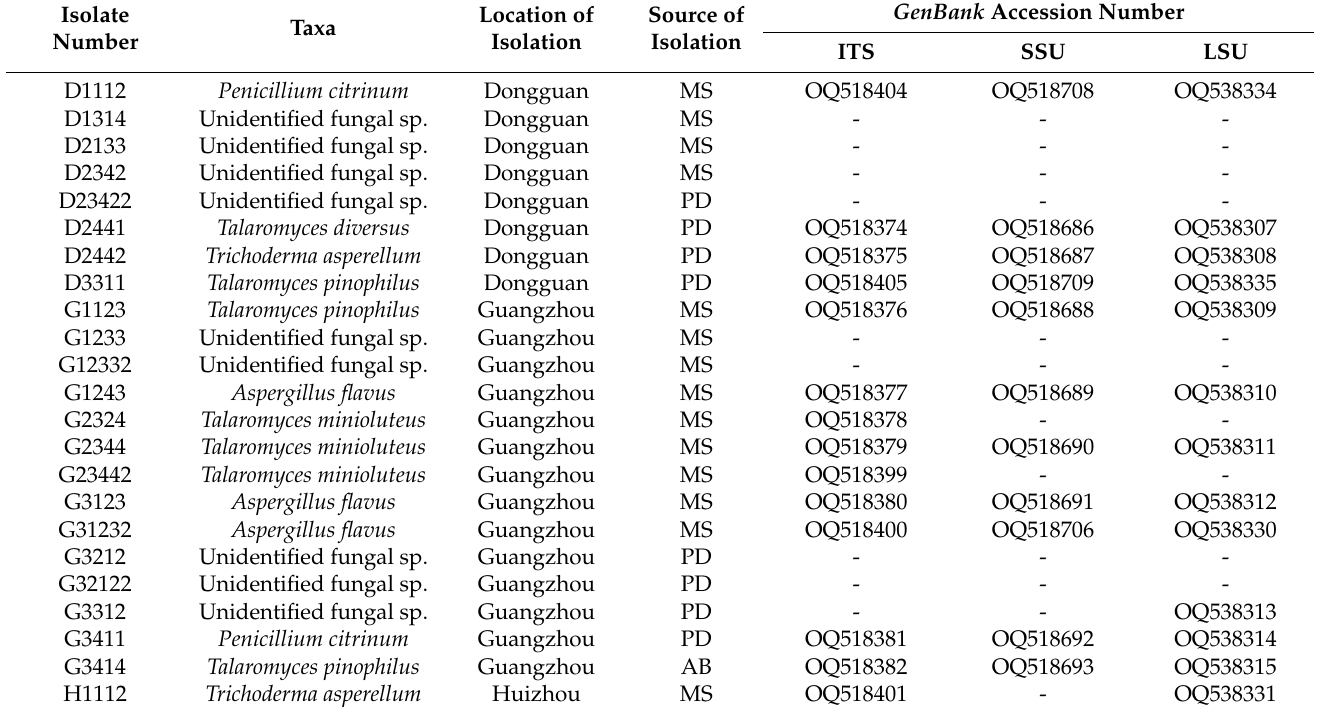
Table 2. Fungal taxa characterized from different substrates collected from five cities of Guangdong Province of